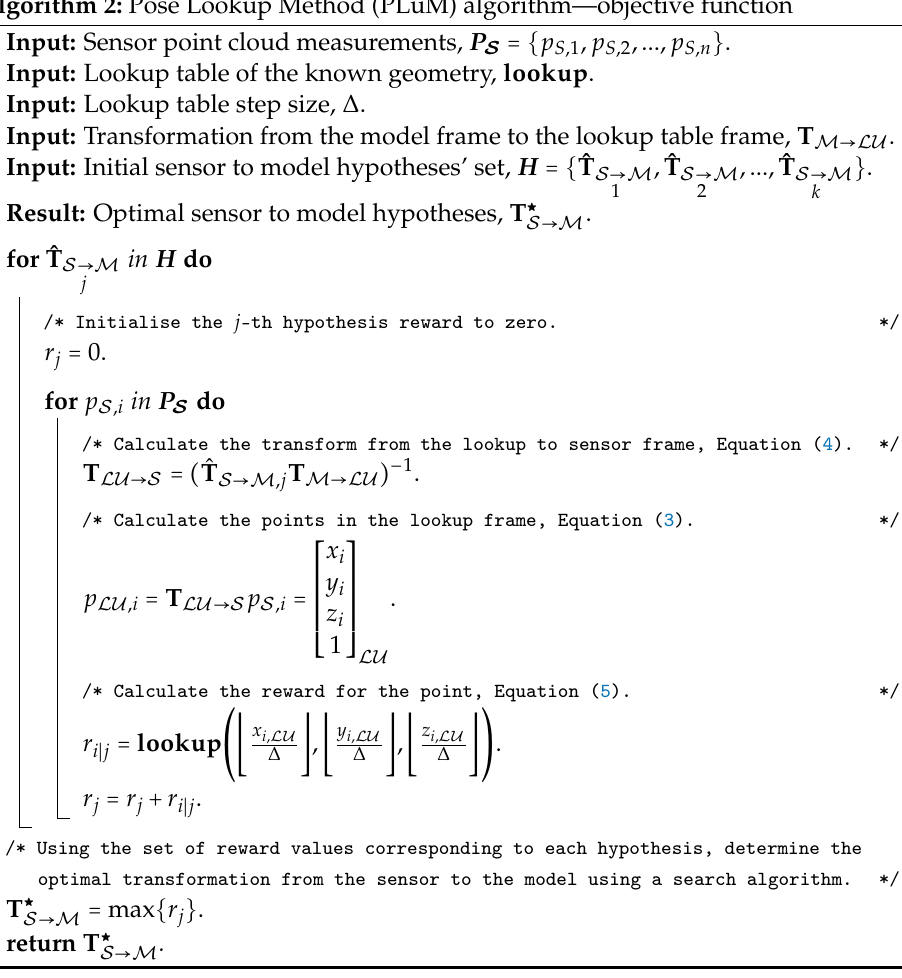
Algorithm 2: Pose Lookup Method (PLuM) algorithm—objective